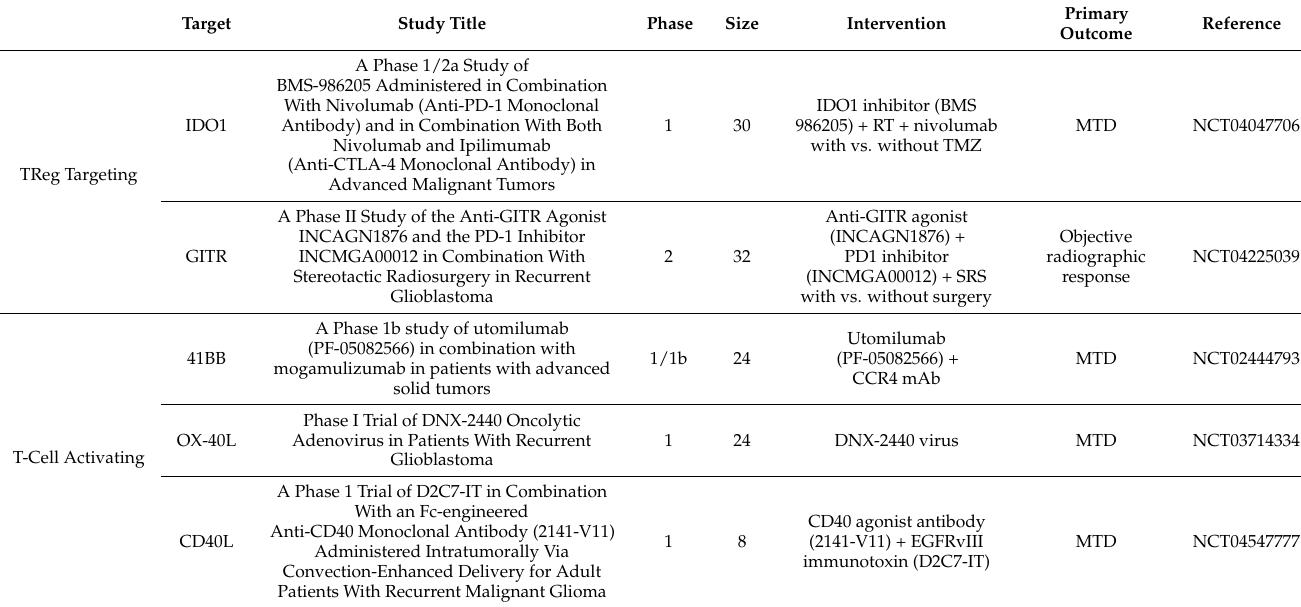
Table 4. Treg and T-cell activator clinical trials for